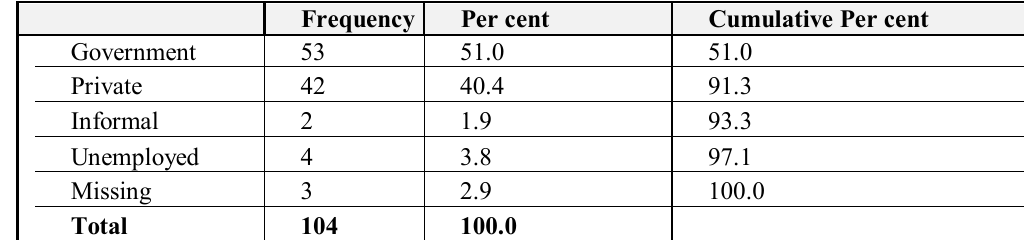
Table 2: Showing employment sectors of respondents